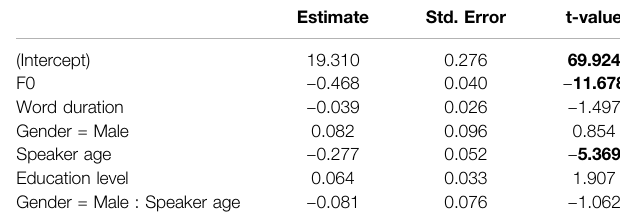
TABLE 4 | Linear mixed-effects regression summary table for CPP. Absolute t-values larger than 2 are regarded to indicate signi fi cance and are highlighted in